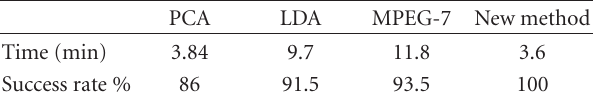
Table 10: The time consumed (in minutes) and the success recognition rate for the di ff erent methods using the ORL database.